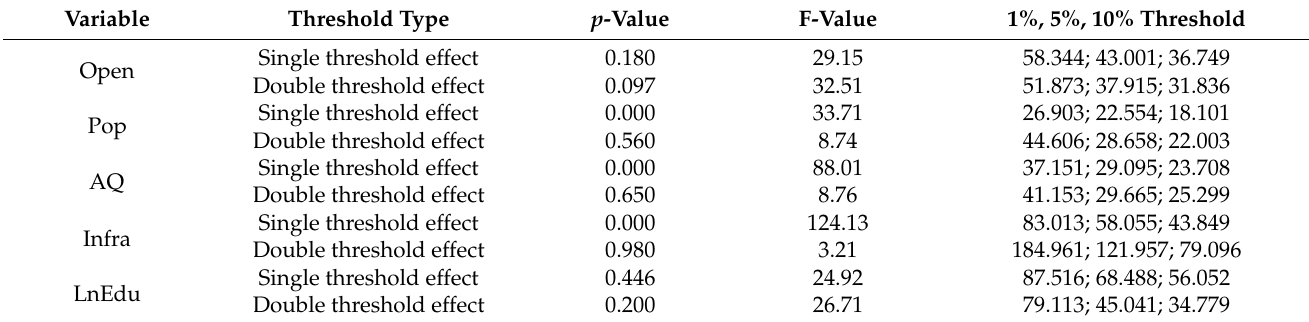
Table 8. Threshold effect test.